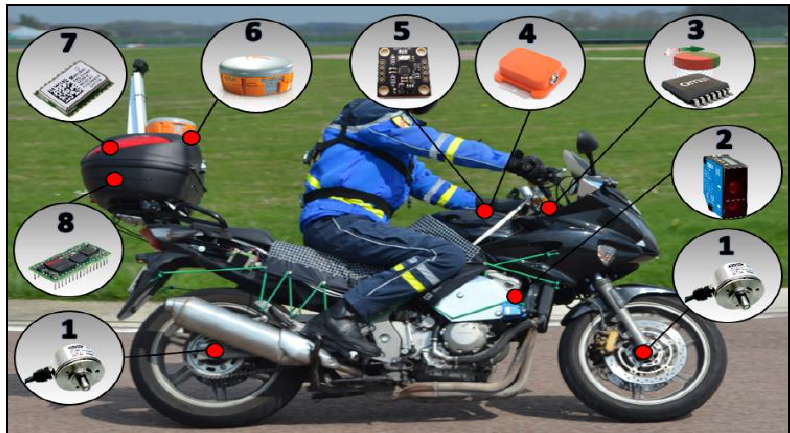
Figure 1. The ANR team instrumented motorcycle.